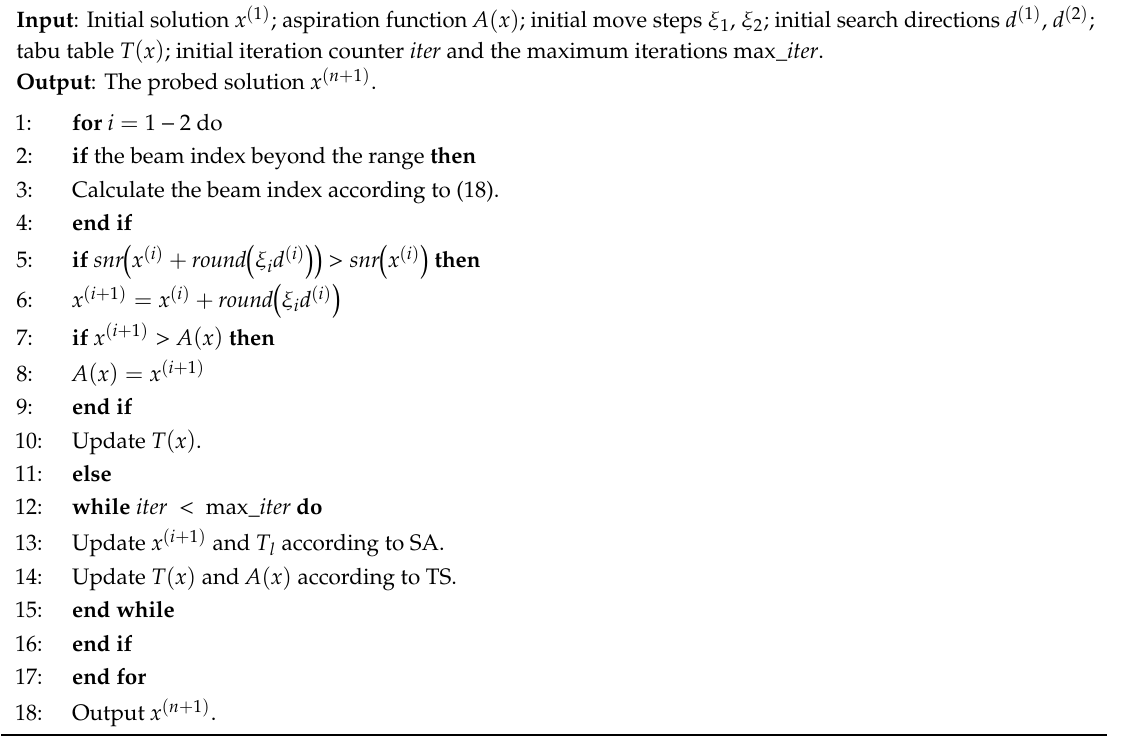
Algorithm 2. The probe moving of the proposed algorithm (Subprogram of Step1 in